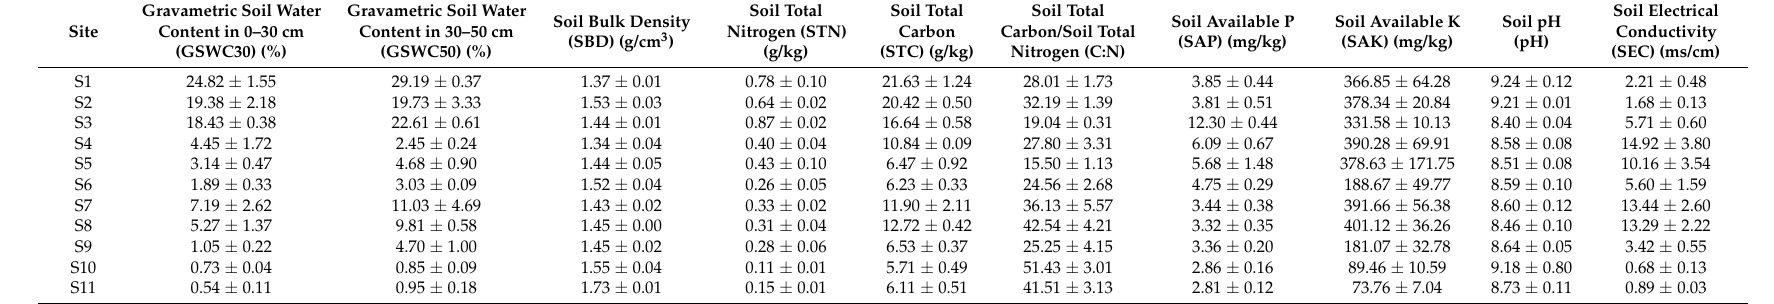
Table 2. Soil properties of sampling sites. Values are means ± SE (Standard Error). The site codes are the same as in Figure 1.